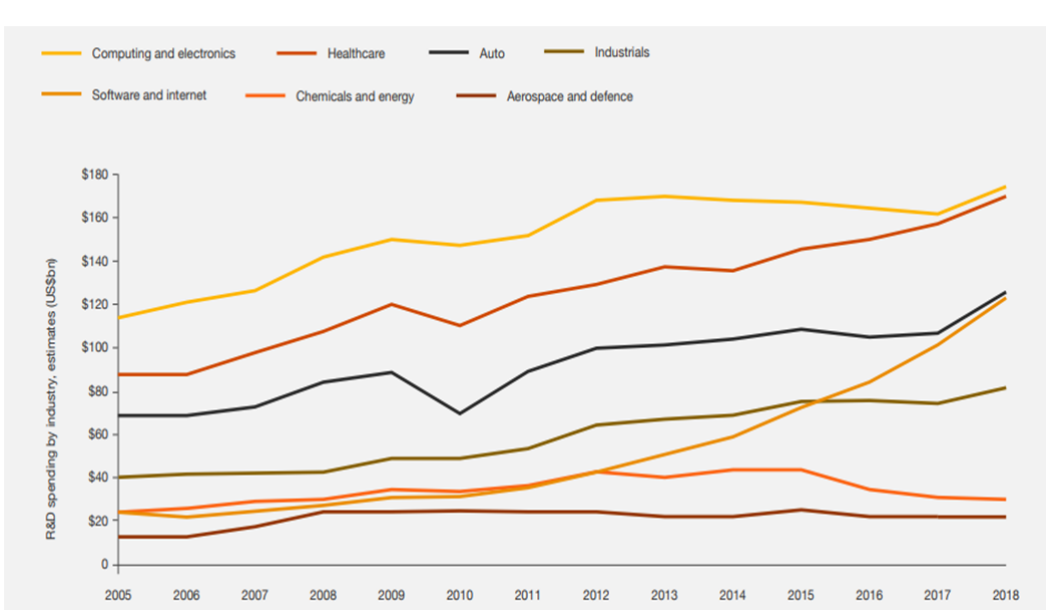
Figure 3. Overall interest in the Aerospace and Defense (marked maroon red) by US investors from 2005